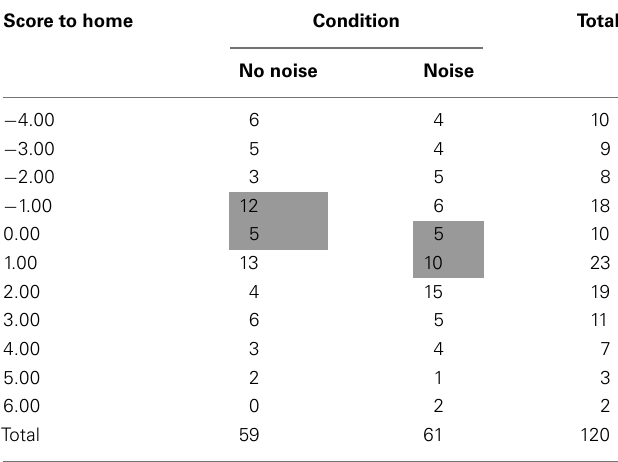
Table 2 | Points in favor of the home boxer awarded by judges in the “noise” and “no noise” conditions (shaded areas indicate decisions where a change in the noise condition could impact on the result of the